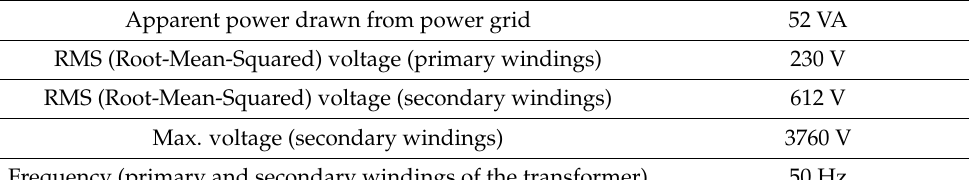
Table 1. Parameters of power supply system for plasma reactor .